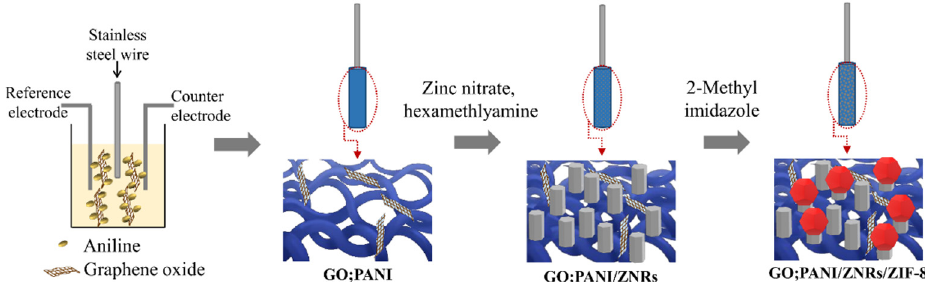
Figure 1. Fabrication process of the adsorbent.